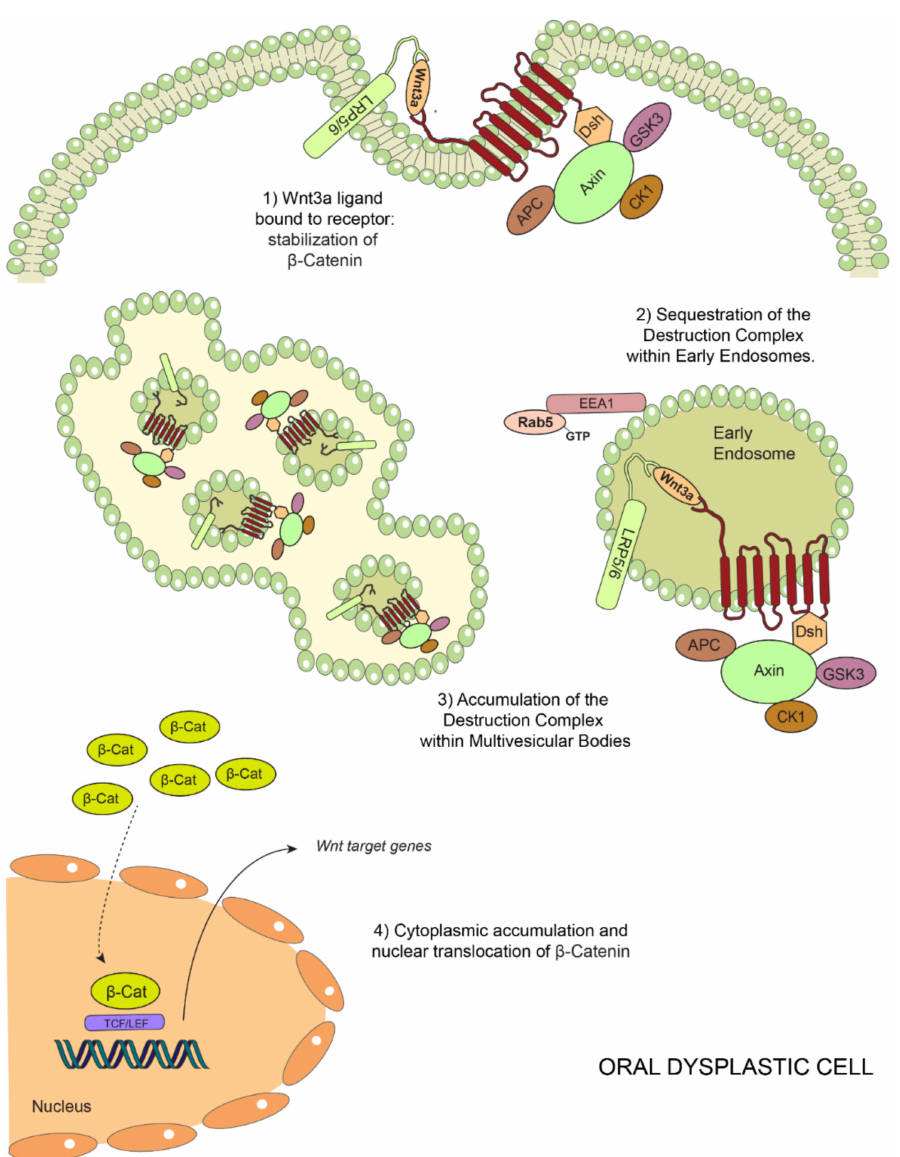
Figure 5. Model of endosomal sequestration of the destruction complex in oral dysplasia. Binding of Wnt3a to Frizzled (FZ) and LRP5 / 6 leads to the recruitment of the destruction complex to the FZ-LRP5 / 6 receptor complex at the plasma membrane. This is followed by a decreased proteasomal degradation of β -catenin ( 1 ). Ligand binding and subsequent posttranslational modifications (not described in this scheme) lead to endocytosis of this supramolecular complex, also known as the “Wnt signalosome complex”, and subsequent tra ffi cking en route to early endosomes and multivesicular bodies in a Rab5-dependent manner ( 2 ). In oral dysplasia, high Wnt3a levels and increased Rab5 activity lead to the enhanced sequestration of the destruction complex within EEA1-positive early